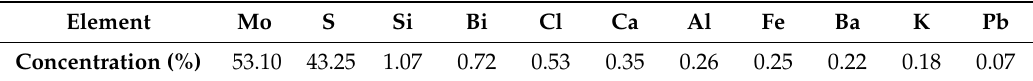
Table 1. Chemical composition of MoS 2 sample.